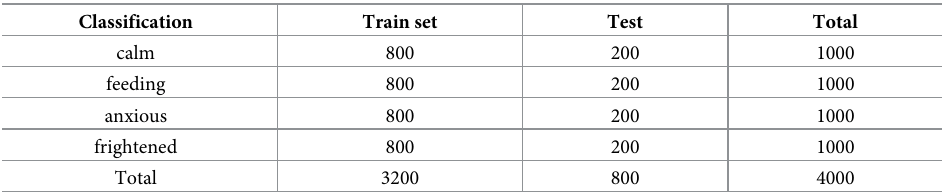
Table 1. Database audio volume classification